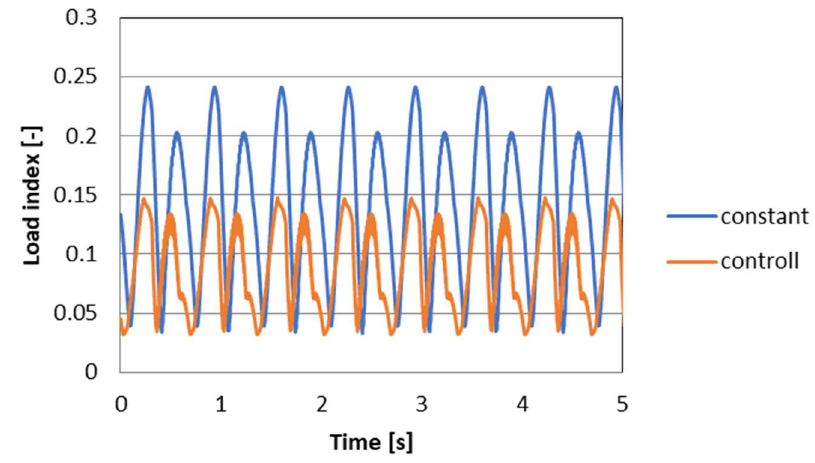
Figure 17. The course of the rate of change of W when controlling the damping force and a constant damping ratio in the suspension of the vehicle model.